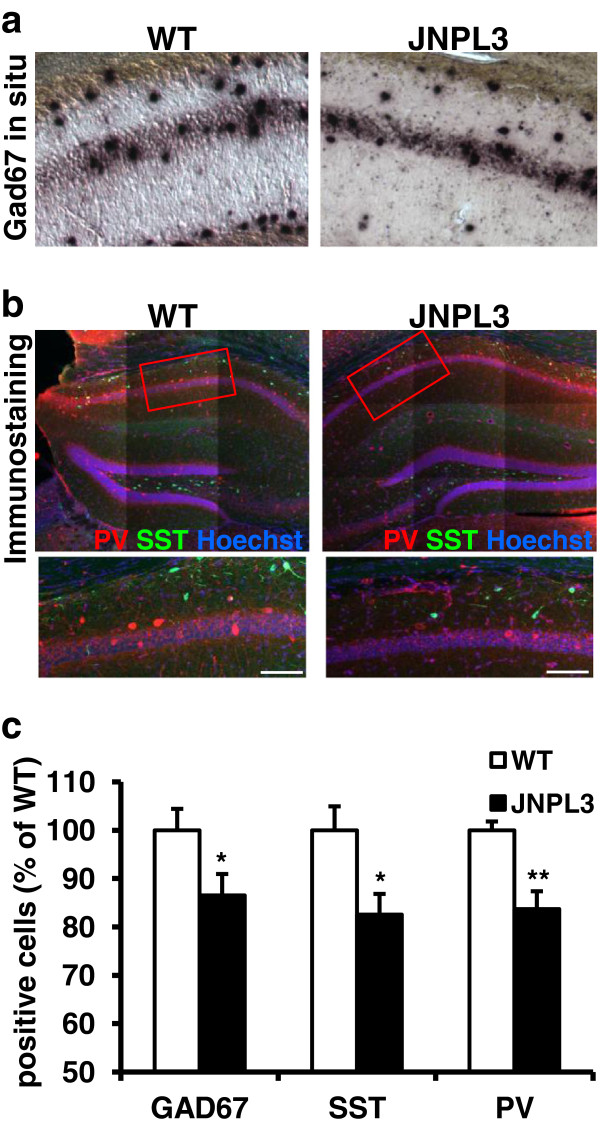
Loss of GABAergic interneurons in hippocampal area CA1. (a)In situ hybridization for the GABAergic marker, GAD67, showed a significant reduction of GAD67-positive neurons in area CA1 (Scale bar = 100 μm). (b) Fluorescent immunostaining against parvalbumin (PV, Cy3) and somatostatin (SST, Cy2), counterstained with Hoechst (Upper image are tiled images of 200× magnification, lower panel 400× magnification). (c) Tg mice showed significantly reduced numbers of GAD67-positive (WT=9 mice, 69 slices, Tg=8 mice, 60 slices, t15=2.143, *P=0.0490), SST-positive (WT=6 mice, 61 slices, Tg=7 mice, 61 slices t11=2.685, *P=0.0212), and PV-positive (WT=7 mice, 61 slices, Tg=7 mice, 61 slices, t12=3.559, **P=0.0039) neurons in CA1 region in series of brain slices. Data presented as mean + SEM.